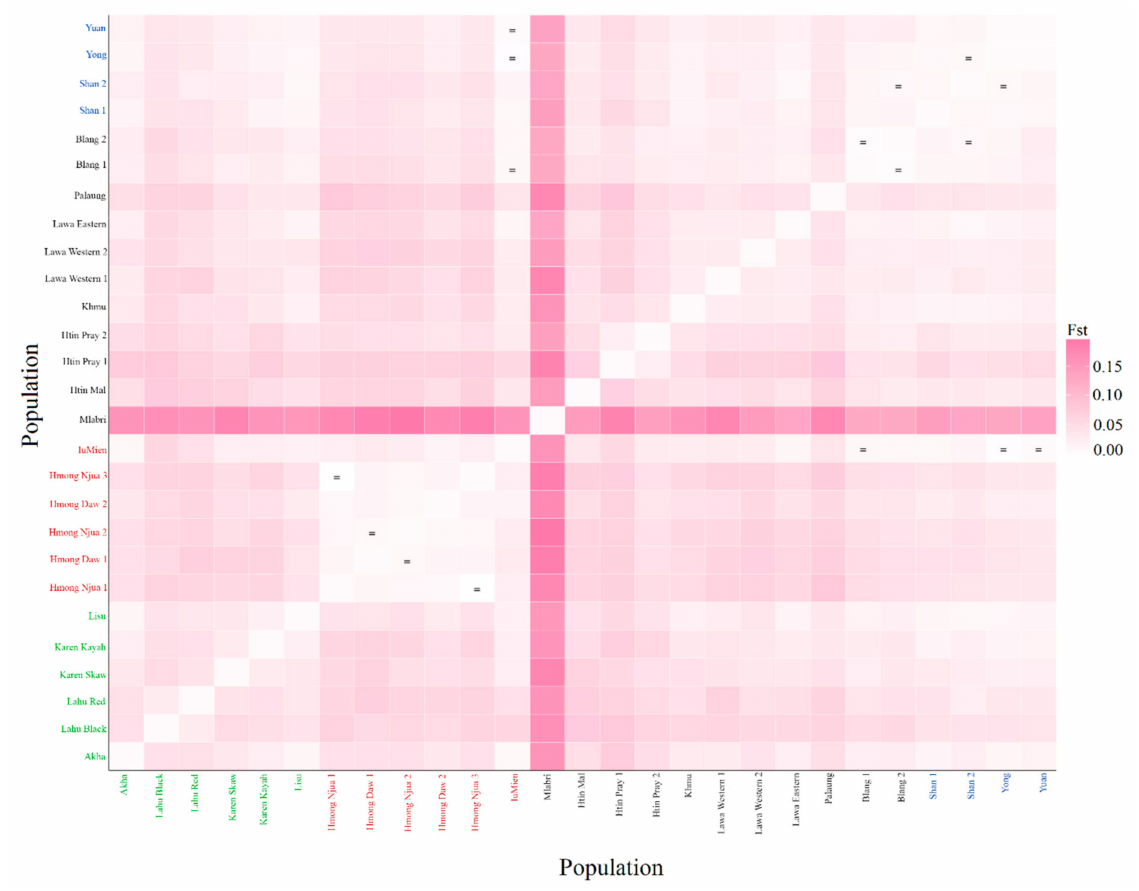
Figure 2. Heat plot of F st values between total 27 populations. Population names are color-coded according to language family; red, green, black, and blue represent HM-, ST-, AA-, and TK-speaking populations,